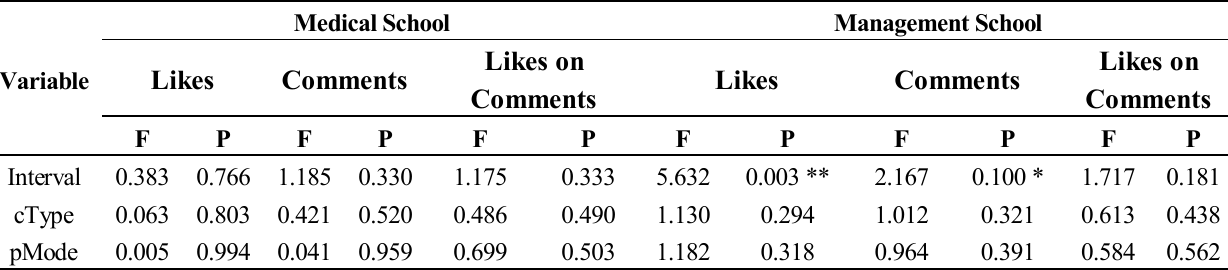
Table 4. The treatment ANOVA